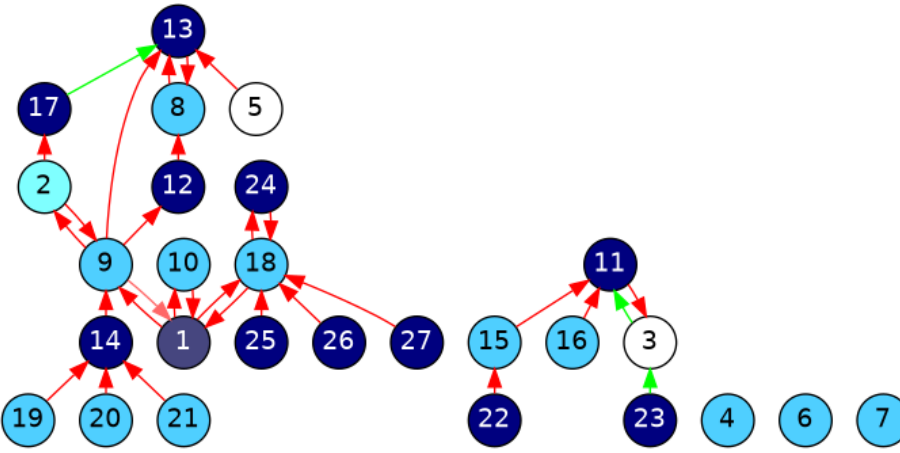
Figure 3. User Debate Graph for the two-sided debate tree of Figure